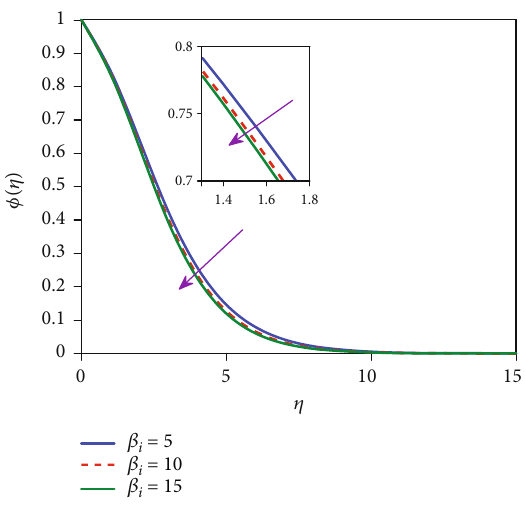
Figure 17: E ff ect of β